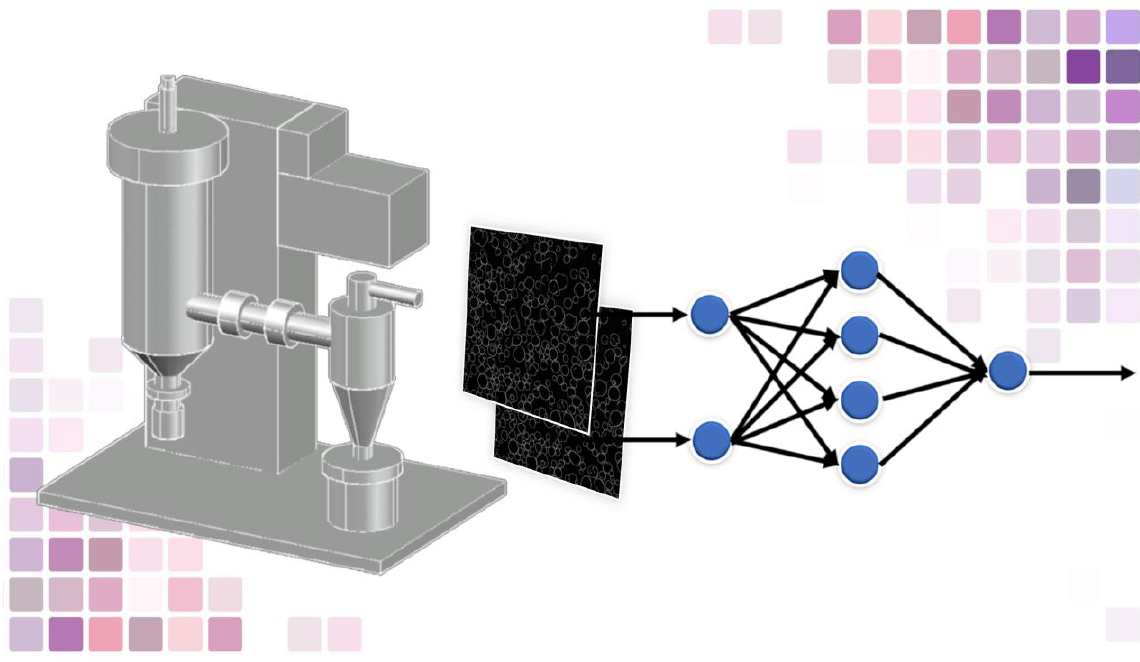
Figure 3. Spray drying supported by artificial neural networks.